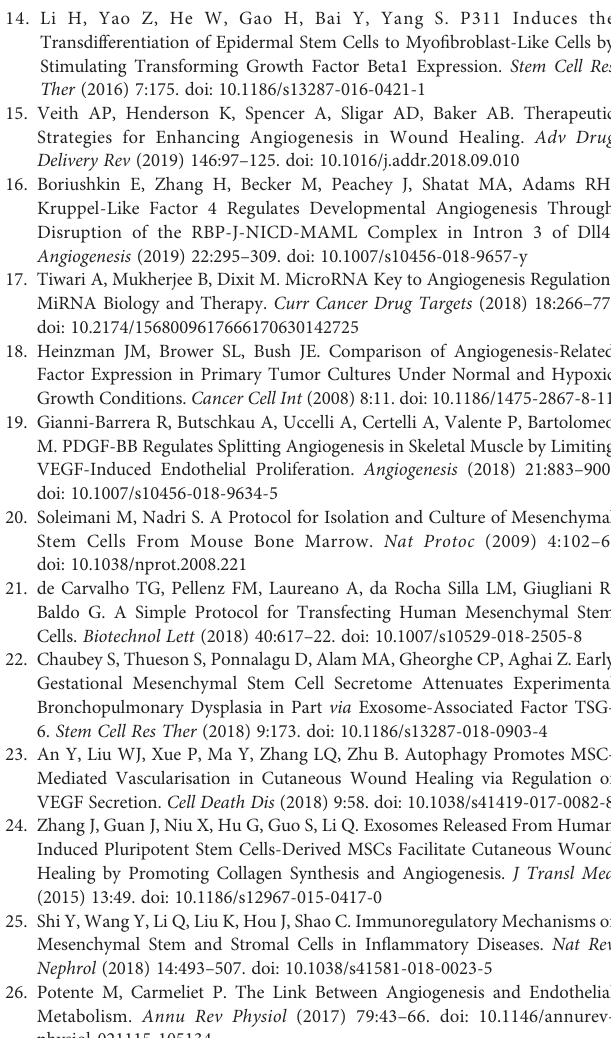
statistically analysed (black arrows, right panel). Scale bar: 50 µm. Data are representative of at least three independent experiments and represent mean ± SD. (ns, no statistical signi fi cance; ***p < 0.001). Supplementary Figure 5 | VEGF is important for P311-mediated pro- angiogenesis and in fl ammatory regulation of MSCs in vivo . (A, B) The expression of VEGF in MSCs Ctrl , MSCs P311+si-Ctrl and MSCs P311+si-VEGF was detected by western blot. (C – F) The effect of P311 on vascularisation was evaluated by counting the number of vessels and ECs in granulation tissue of mice with MSCs Ctrl , MSCs P311 and MSCs P311+si-VEGF administration. (C, D) The representative images of vessel formation in wound tissue were shown (left panel), and the number of vessels was counted and statistically analysed (right panel). (E, F) The representative H&E images of granulation tissues were shown (left panel), and the number of vessels were counted and statistically analysed (black arrows, right panel). Scale bar: 50 µm. (G, H) Representative immunohistochemical images of VEGF were shown (black arrows, left panel), and the production of VEGF in granulation tissues was statistically analysed. (right panel). Scale bar: 50 µm. (I) Supernatants of wound tissue extract at day 7 post-injury were applied for identifying the contents of VEGF in mice with MSCs Ctrl , MSCs P311 and MSCs P311+si-VEGF treatment by means of ELISA. (J – O) Representative immunostaining images for TNF- a , IFN- g and IL-10 in granulation tissues were shown (left panel), and the expression of these markers was statistically analysed (right panel). Scale bar: 50 µm. (P, Q) Representative